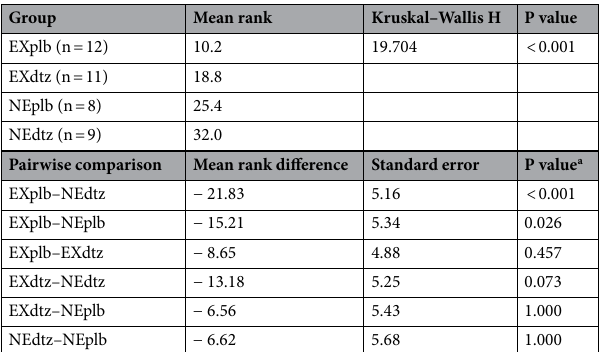
Table 3. Comparison of tacrolimus dose-adjusted area under the 12-h curve at day 7 post-kidney transplantation among groups. EXplb CYP3A5 expressers with placebo group, EXdtz CYP3A5 expressers with diltiazem group, NEplb CYP3A5 nonexpressers with placebo group, NEdtz CYP3A5 nonexpressers with diltiazem group. a Bonferroni correction for multiple